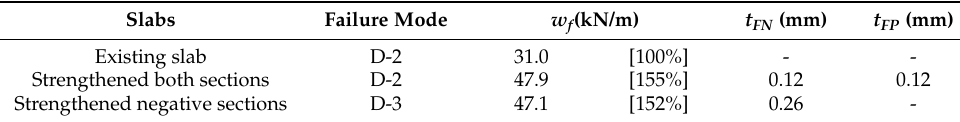
Table 5. The strengthened slab capacities for the design